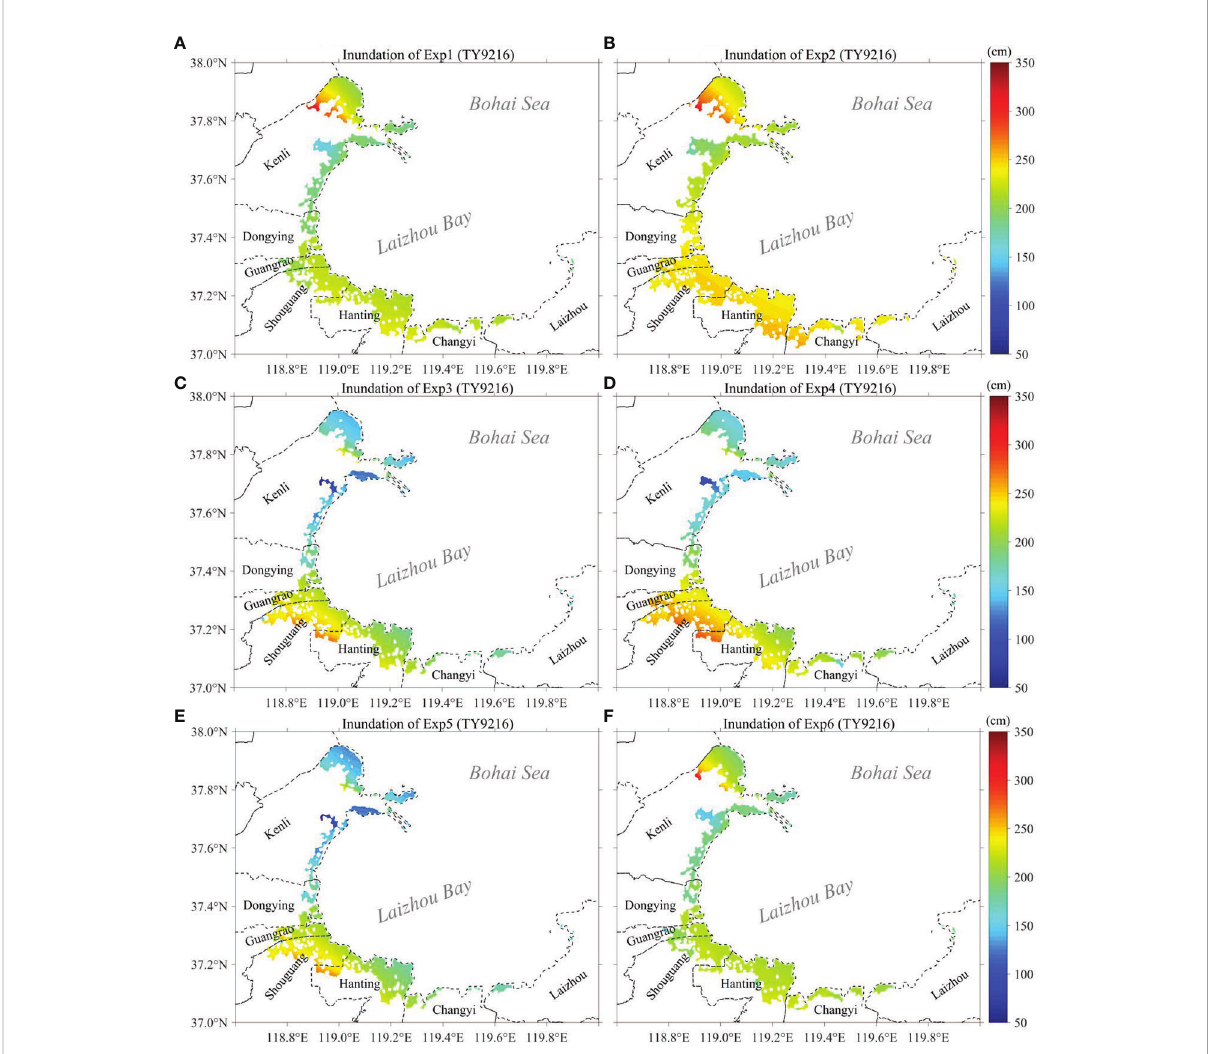
FIGURE 6 Inundation distributions and inundation depth (unit: cm) of TY9216 under Exp1 (A) , Exp2 (B) , Exp3 (C) , Exp4 (D) , Exp5 (E) , and Exp6 (F) along the